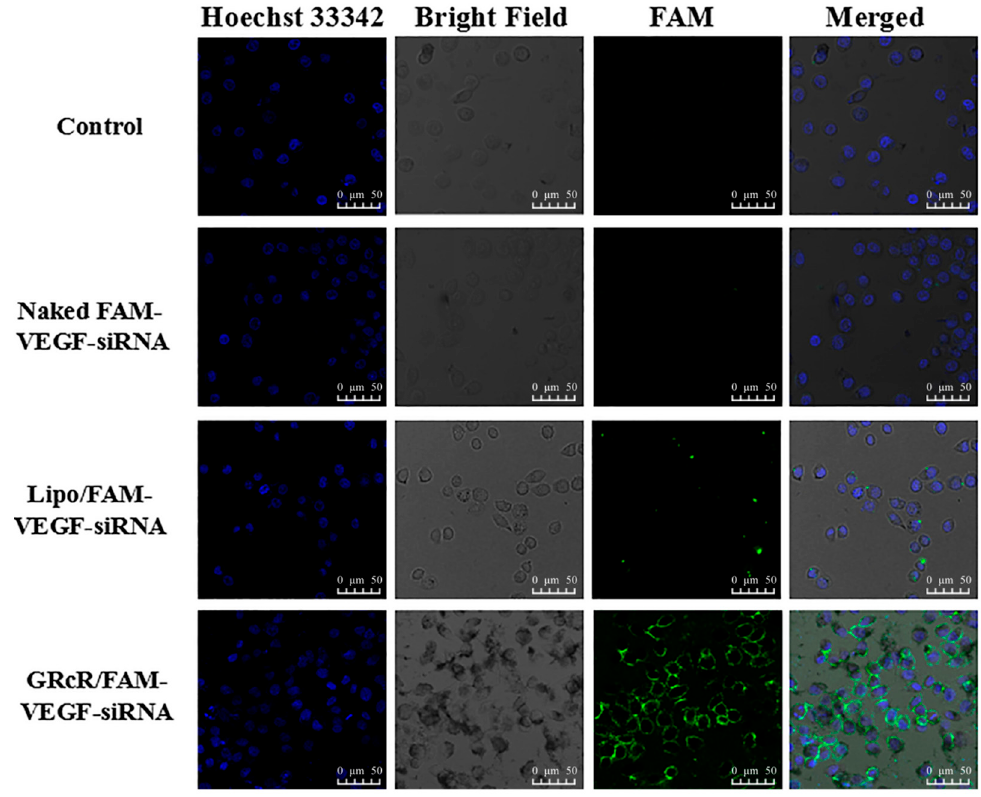
Figure 11. Cellular uptake of the FAM-labeled VEGF-siRNA in HeLa cells.